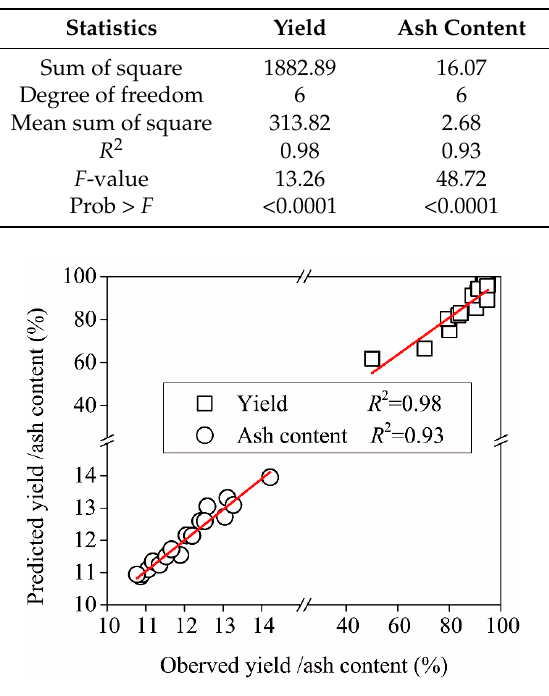
Figure A1. Actual and predicted values of the response variables.